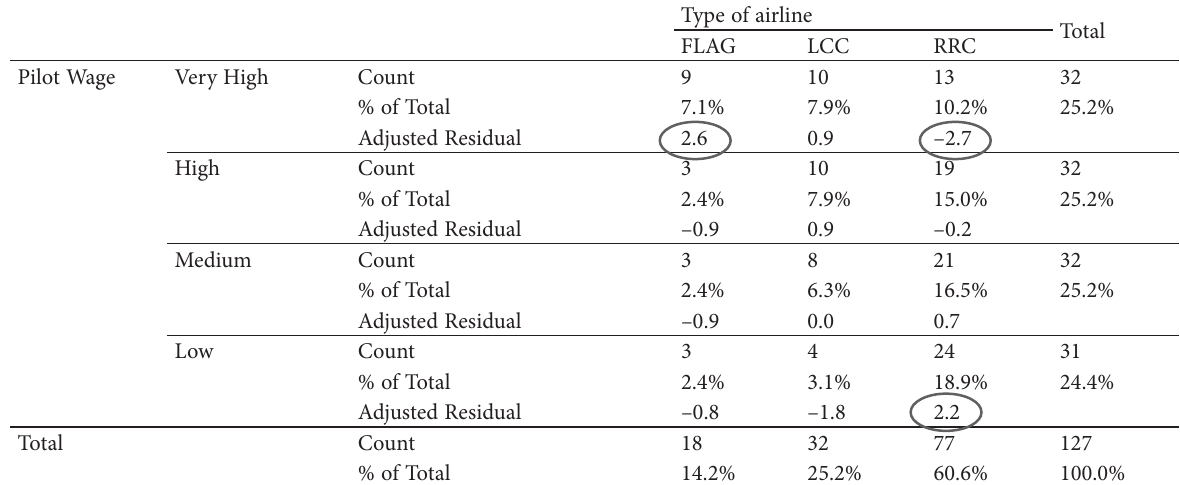
Table 7. First Officer Top 2008. Cross tabs adjusted and standardised by type